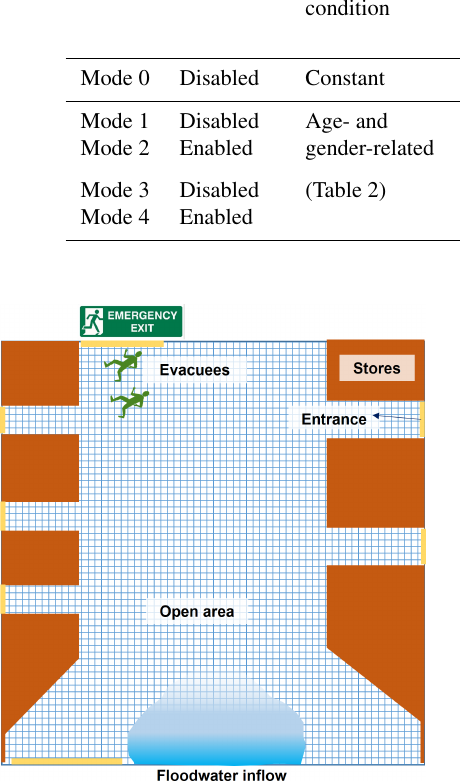
Figure 2. Sketch of the shopping centre: the meshed area in blue indicates the open area and corridors where pedestrians can walk to the entrance doors (coloured in yellow). Once the flood starts, evacuating pedestrians will go to the emergency exit (on the north side). The blocks in brown indicate terrain features assuming they are stores, and the blue-shaded area in the southern part of the figure shows the location where the floodwater started to propagate.